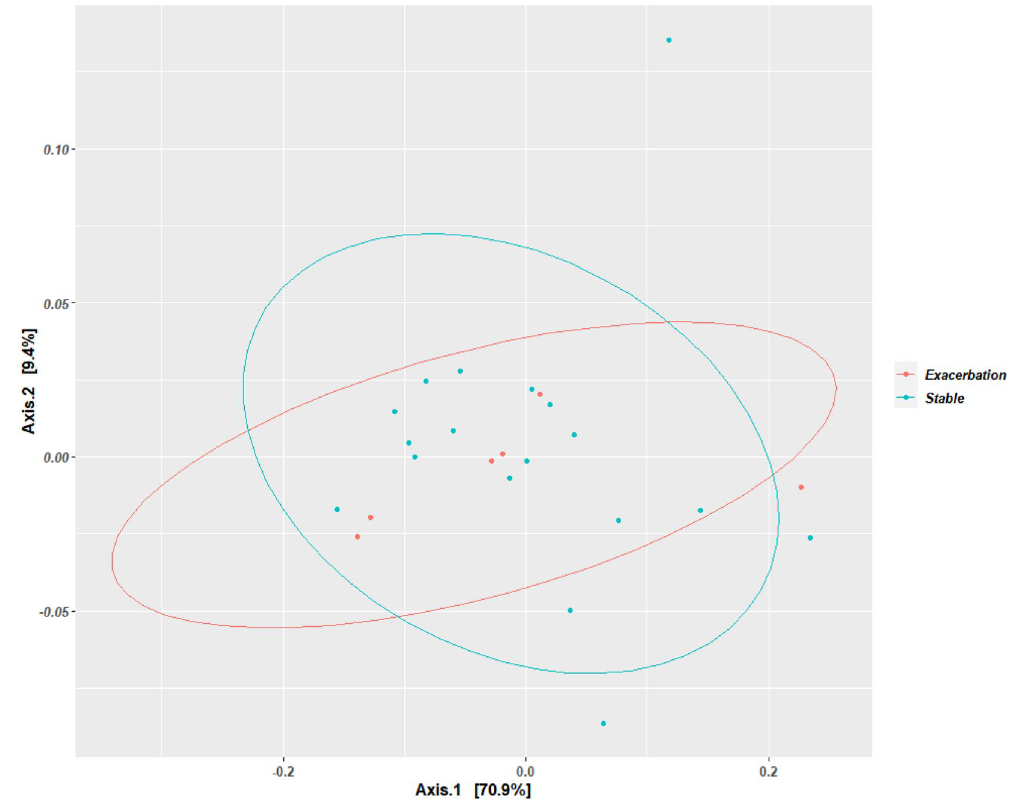
Figure 4. Principal component analysis (PCoA) plot derived using weighted UniFrac diversity measure comparing the different disease states of COPD in the sputum microbiome The ellipses show the different states of disease with the exacerbated state (n = 6) indicated in red and the stable state (n = 18) indicated in blue; with the dots represent in each